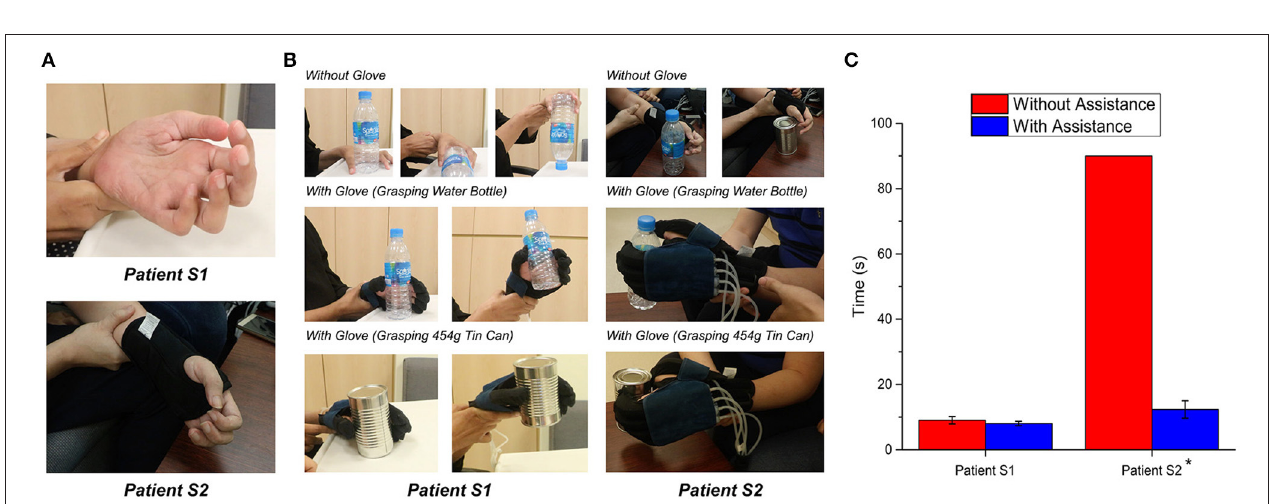
FIGURE 9 | Evaluation of the glove with stroke patient S1 and S2. (A) Hand conditions of patients. (B) Comparison of grasping performances with and without assistance of glove. (C) Time taken to complete the grasping tasks ( n = 6 for each patient; P = 0.06 for S1, P = 0.02 for S2, paired t test, * p < 0.05.). The actuators of the glove were pressurized at 120